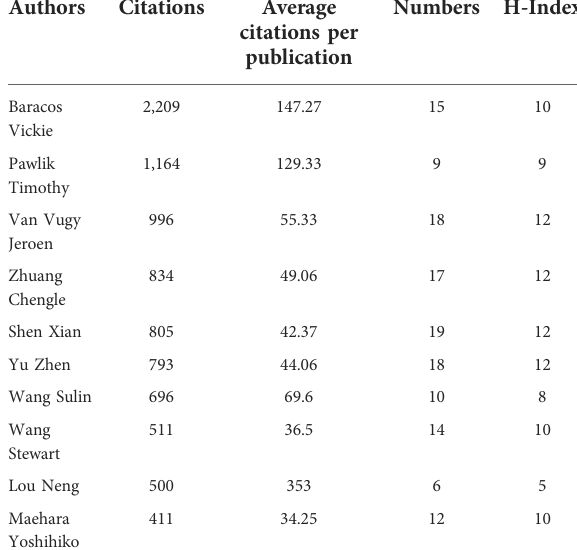
TABLE 5 The top 10 most in fl uential authors focusing on the relationship between sarcopenia and